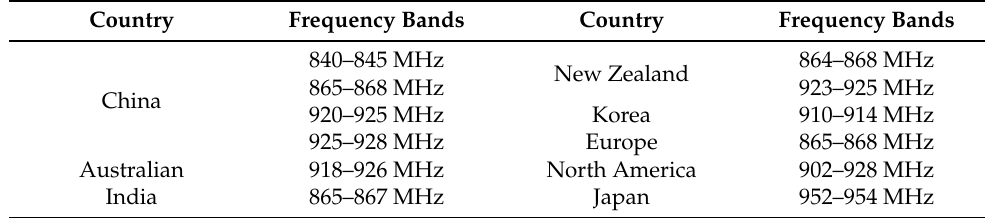
Table 1. UHF frequency bands adopted by major